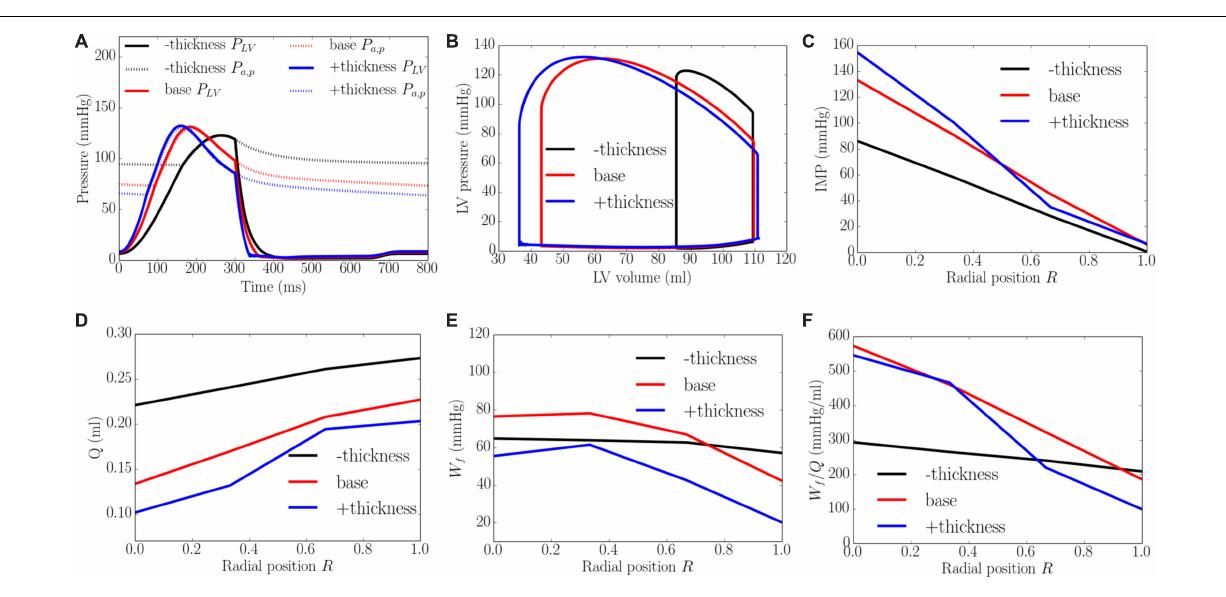
FIGURE 8 | Effects of wall thickness on (A) Pressure waveforms; (B) LV pressure-volume loop; Transmural distribution of (C) IMP; (D) Total coronary flow over a cardiac cycle; (E) Work density over a cardiac cycle W f ; (F) Work density-perfusion mismatch index ratio W f / Q . “–thickness,” “base,” and “+thickness”